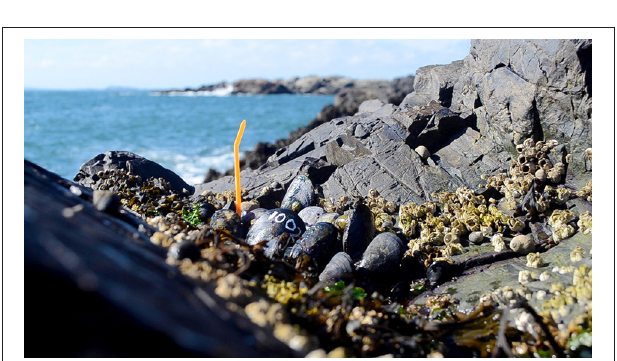
FIGURE 6 | A single robomussel deployed in growth position within a live mussel bed. The presence of surrounding organisms helps improve biomimetic logger